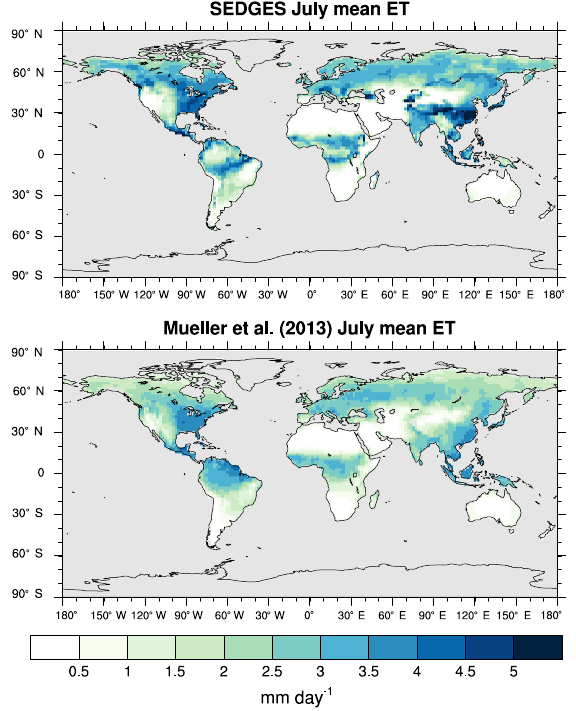
Figure 16. July mean ET for SEDGES and the Mueller et al. (2013) reference dataset for the 1989–2005 period over non-glaciated